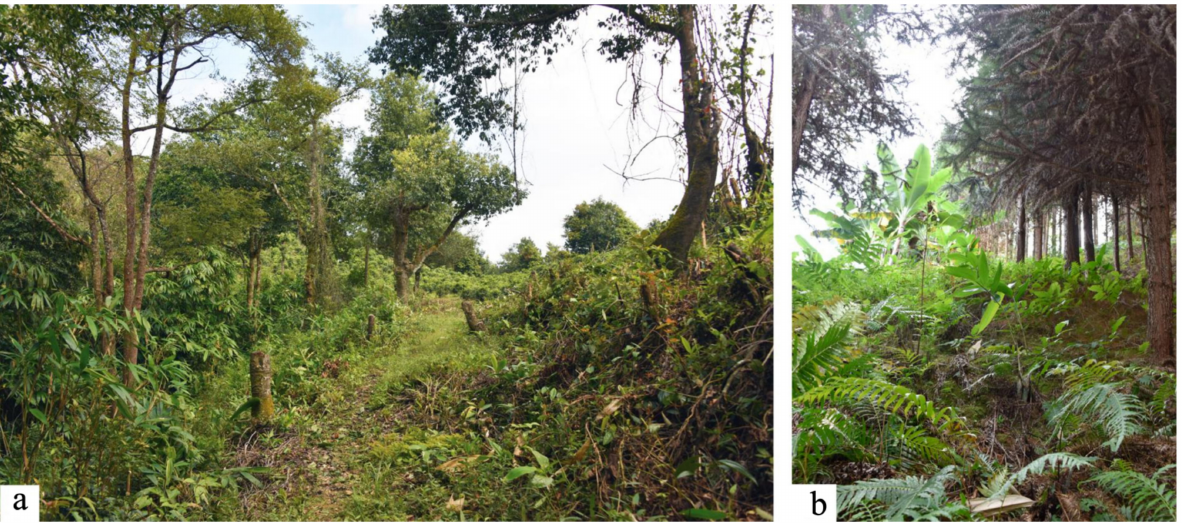
Figure 2. Remnants of F. strictus and tea forests ( a ). The remaining F. strictus forest, sand forest, and banana forest ( b